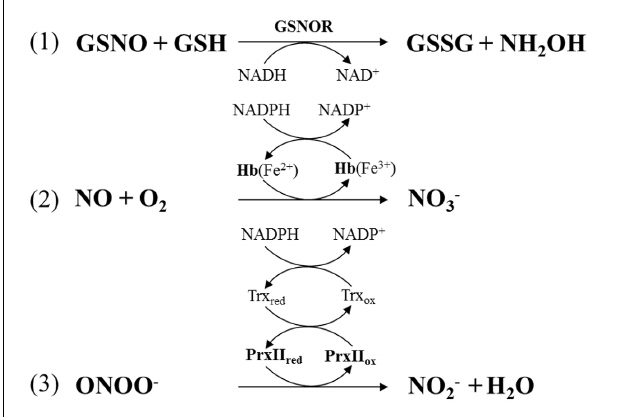
FIGURE 3 | Enzymatic regulation of NO homeostasis by (1) S-nitrosogutathione reductase (GSNOR), (2) hemoglobin (Hb), and (3) peroxiredoxin IIE (PrxIIE). PrxIIE is reduced by thioredoxin